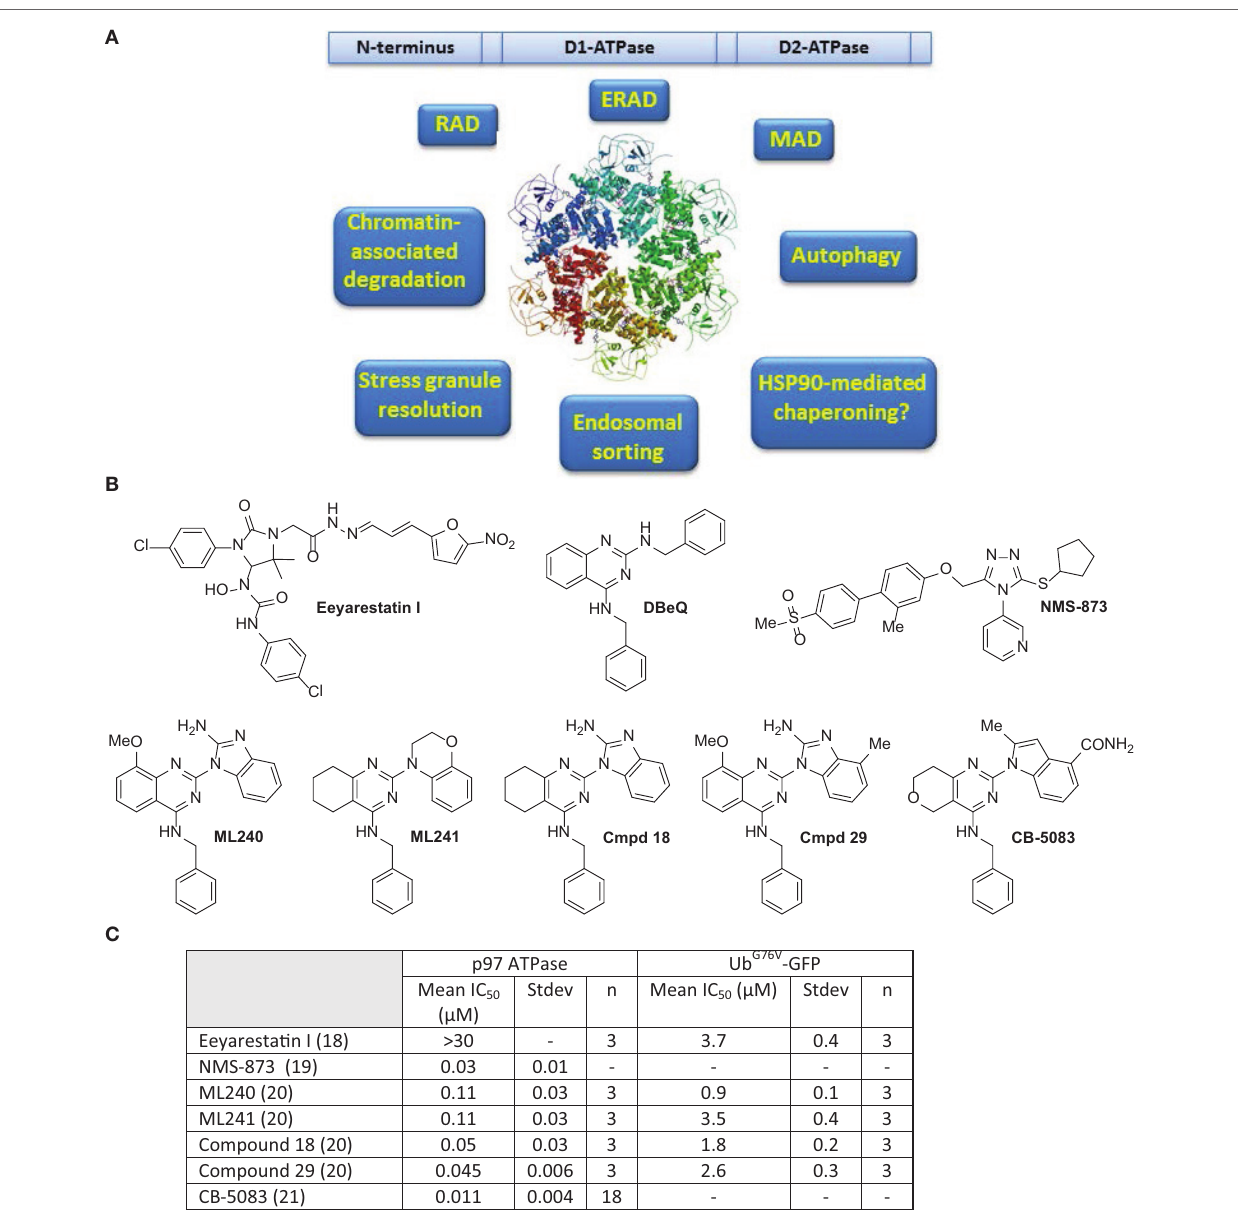
FiGURe 1 | (A) Domain structure, ribbon diagram of p97 hexameric structure (11), and functions of p97 are summarized. (B) Select inhibitors of p97 ATPase. Chemical structures for Eeyarestatin I, DBeQ, NMS-873, ML240, ML241, compound 18, compound 29, and CB-5083. (C) Comparison of IC 50 values for shown compounds for p97 in biochemical and cell-based assays as reported in Ref.